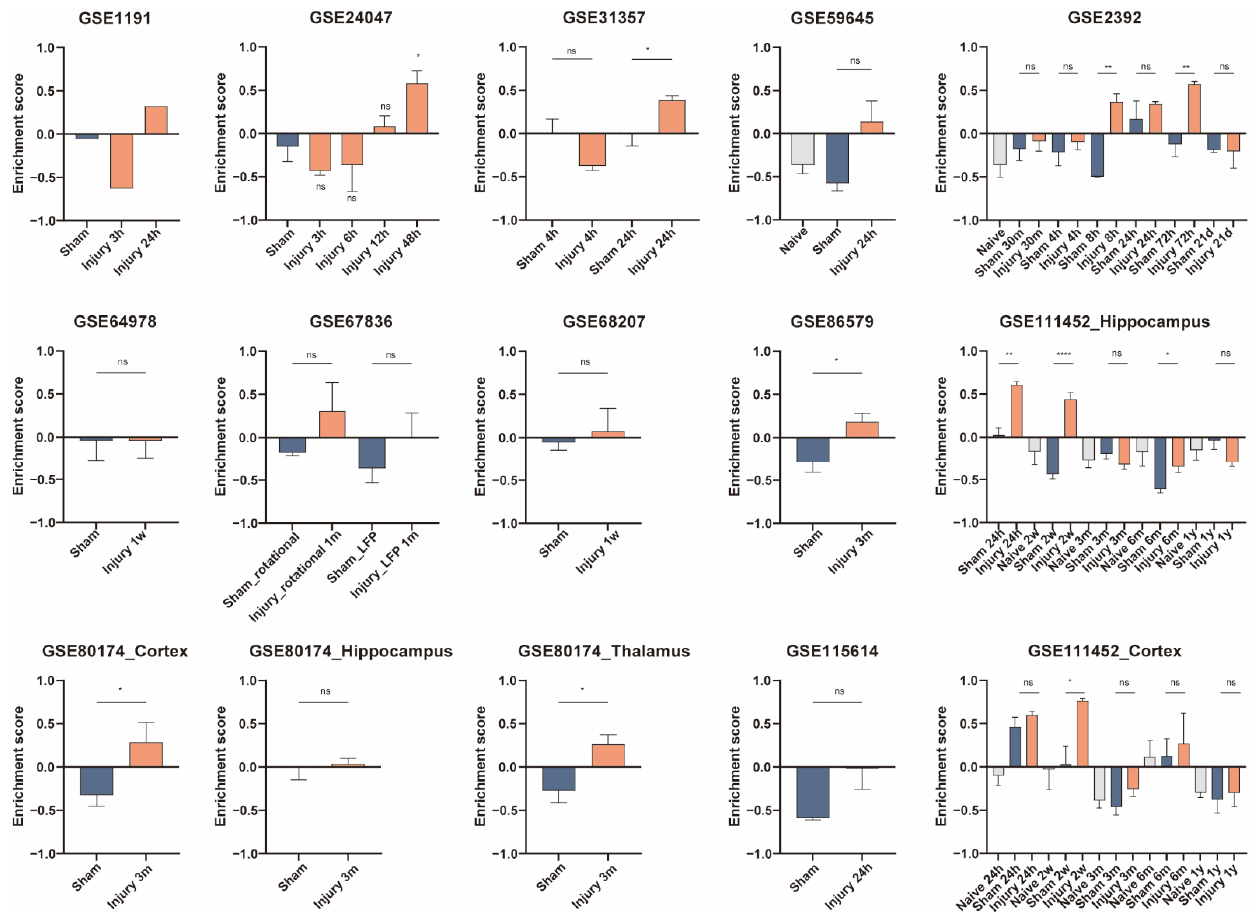
Figure 6. Gene set variation analysis (GSVA) for PM in the validation datasets. GSVA enrichment scores from the validation data sets are plotted as bar graphs. The GEO accession number of the dataset is labeled in each panel. Samples from multiple regions in one dataset are compared separately. Information is labeled in the corresponding panels if the dataset contains samples with different treatments or harvested at various postinjury time points. For GSE1911, N = 1 for each group; for GSE24047, N = 4 for Sham group and N = 3 for the other groups; for GSE31357, N = 4 for each group; for GSE59645, N = 2 for Sham group and N = 3 for Naïve group and Injury 24-h group; for GSE2392, N = 3 for Naïve, Injury 4-h, Injury 8-h, Injury 24-h, Injury 72-h, and Injury 21-d groups, N = 4 for Sham 30-m and Sham 4-h groups, N = 5 for Injury 30-m group, N = 2 for Sham 8-h, Sham 24-h, Sham 72-h, and Sham 21-d groups; for GSE64798, N = 5 for each group; for GSE67836, N = 4 for Sham_LFP group and N = 3 for the other groups; for GSE68207, N = 4 for each group; for GSE86579, N = 5 for Sham group and N = 6 for Injury 3-m group; for GSE111452_Hippocampus, N = 2 for Sham 24-h group, N = 3 for Injury 24-h group, and N = 4 for the other groups; For GSE80174_Cortex, GSE80174_Hippocampus, and GSE80174_Thalamus, N = 5 for each group; for GSE115614, N = 2 for Sham group and N = 3 for Injury 24-h group; for GSE111452_Cortex, N = 4 for each group. **** p < 0.0001, ** p < 0.01, * p < 0.05. Data are shown as means ±